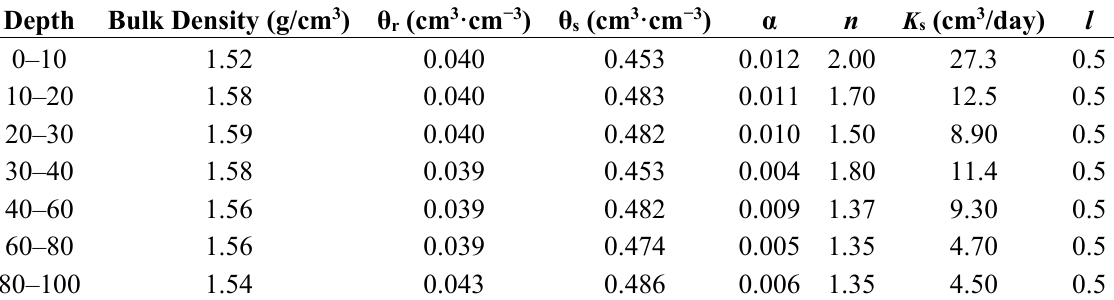
Table 2. Soil hydraulic parameters of the van Genuchten-Mualem model at the experiment site. Saturated hydraulic conductivity ( K s ) and saturated water content ( θ s ) were measured values, whereas n , α , and θ r were estimated values through inverse simulation.